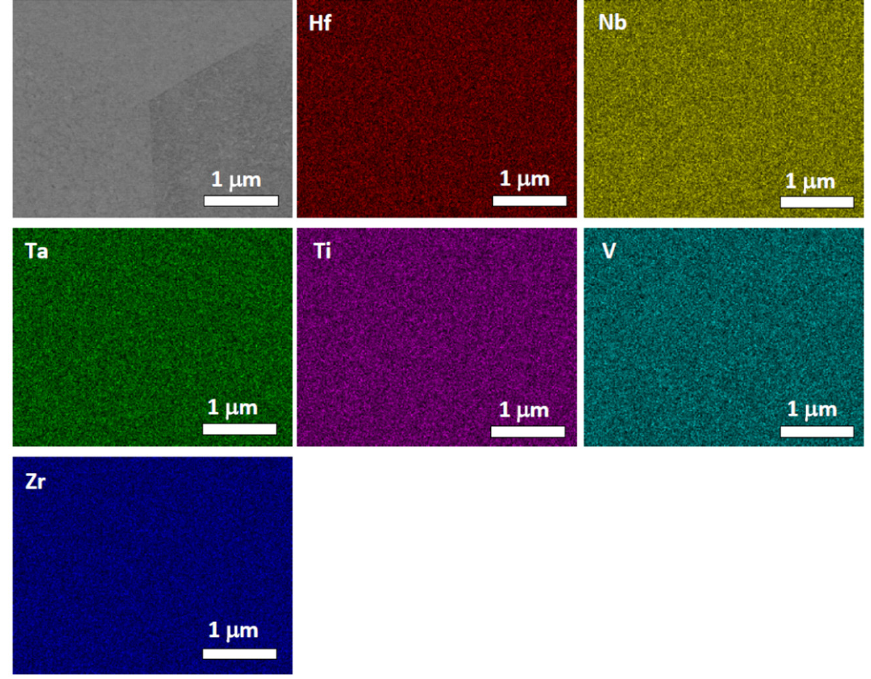
Figure 20. EDS elemental maps of as-cast HfNbTaTiVZr alloy annealed at 1200 ◦ C (SEM micrograph in the upper left panel shows the inspected region).